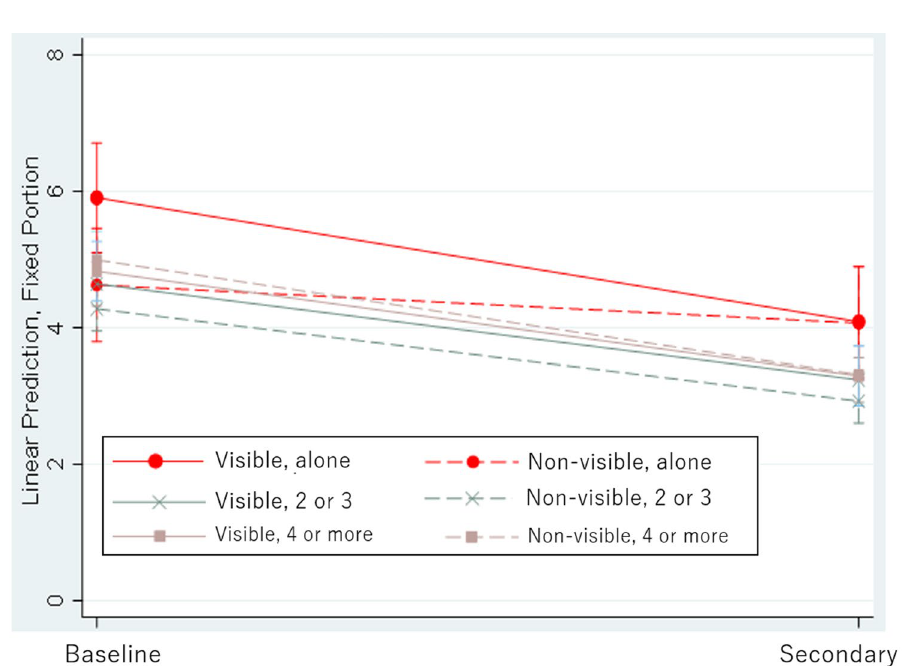
Figure 1. Predictive margins of Kessler Psychological Distress Scale score change by the interaction term of sea visibility and household size between the baseline and the secondary survey for living